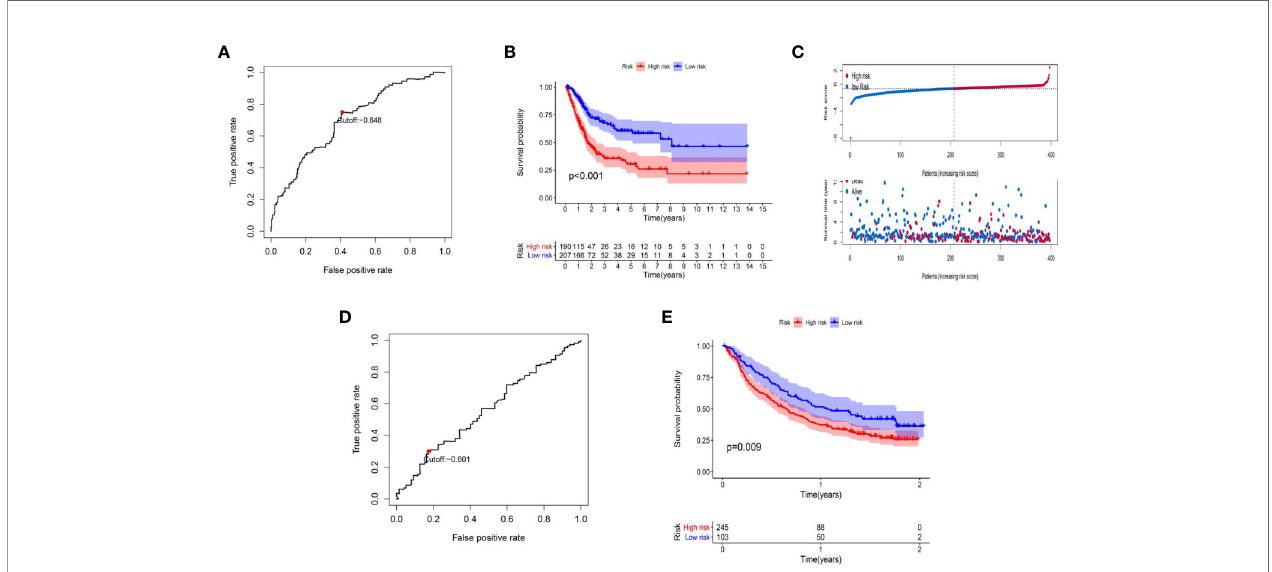
FIGURE 2 | Construction of IRL-based signature. (A) Time-dependent ROC curve of IRL-signature in TCGA-BLCA cohort. The optimal cut-off value of LncRNA signature is -0.648, and patients are divided into high-risk group and low-risk group according to the cut-off value. (B) Kaplan – Meier curves of overall survival according to IRL-signature groups in the TCGA cohort. (C) Distribution of risk score, survival status of patients in in TCGA-BLCA cohort. (D) Time-dependent ROC curve of IRL-signature in IMvigor dataset. The optimal cut-off value of IRL-signature is -0.648, and patients are divided into high-risk group and low-risk group according to the cut-off value. (E) Kaplan – Meier curves of overall survival according to IRL-signature groups in the IMvigor dataset.